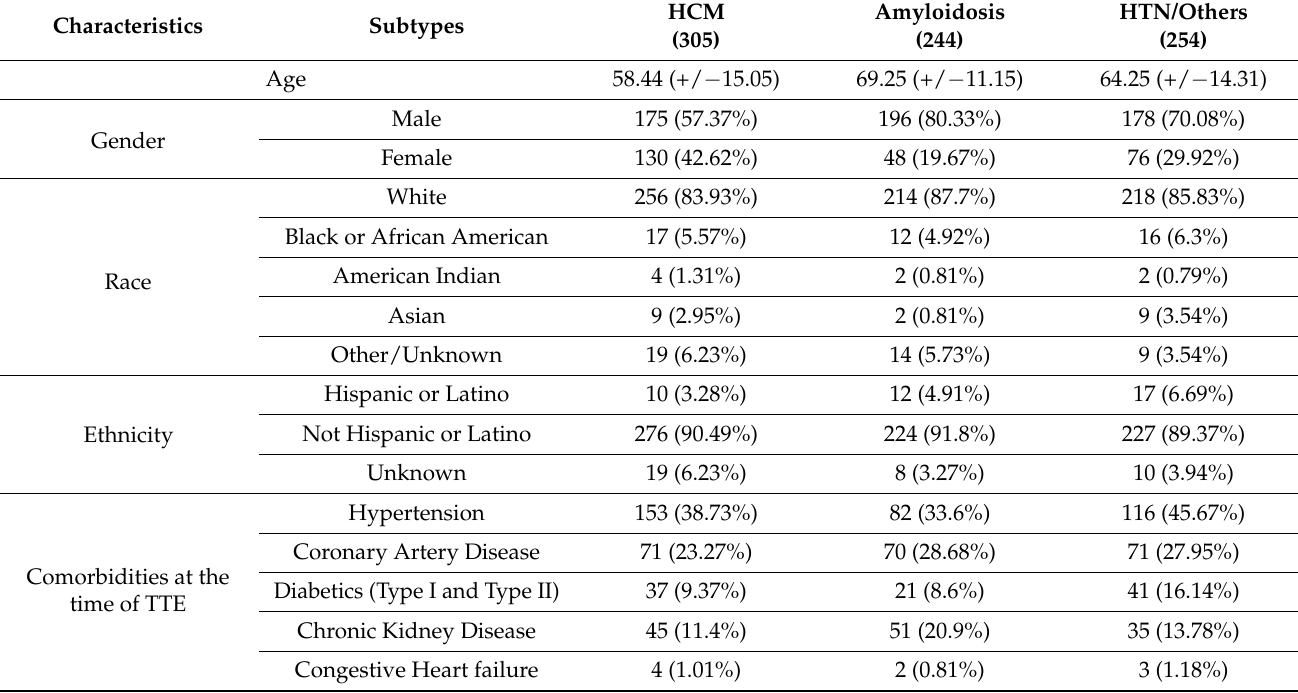
Table 1. Patient characteristics—age, gender, race, ethnicity, and common